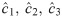
Identification of unknown parameters of systems (19) and (13).(a) c^1, c^2, c^3 ; (b) b^1, b^2, b^3, b^4 .